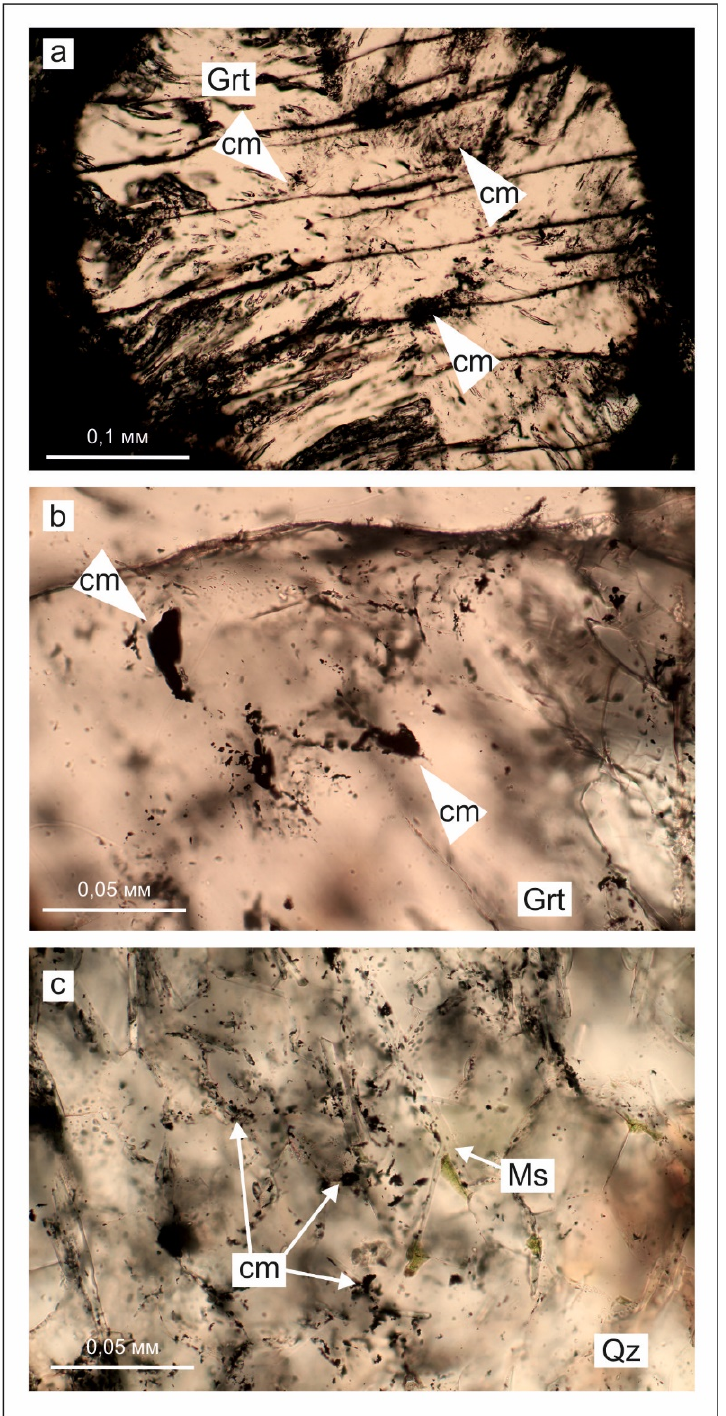
Figure 6. Photomicrograph of carbonaceous material (cm) in garnet ( a , b ) and muscovite ( c ) from the sample oc-24.